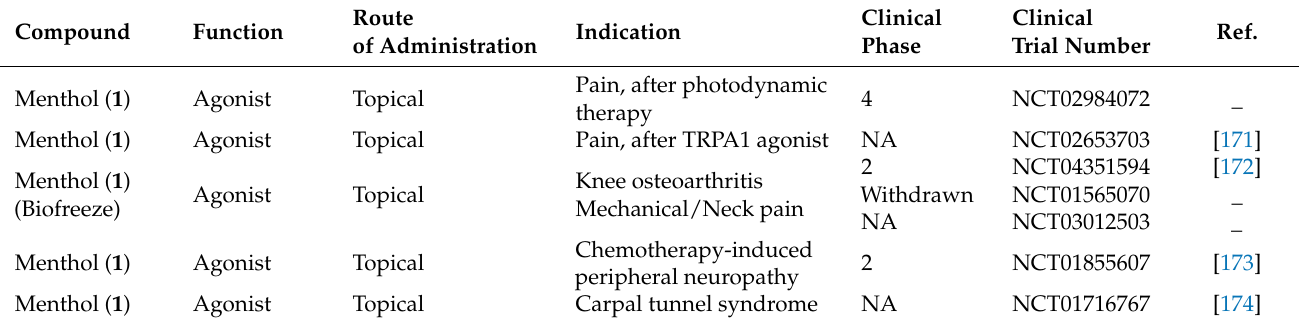
Table 3. Selection of main clinical studies on TRPM8-targeted therapies and diagnosis probes a . Route Compound Function Indication of Administration